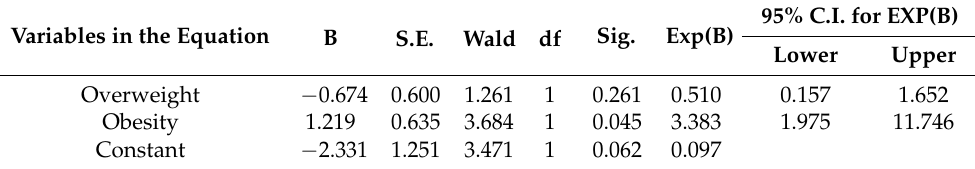
Table 3. Logistic regression analysis (Enter method) taking stroke as a dependent variable for patients with paroxysmal AF for overweight and obesity.